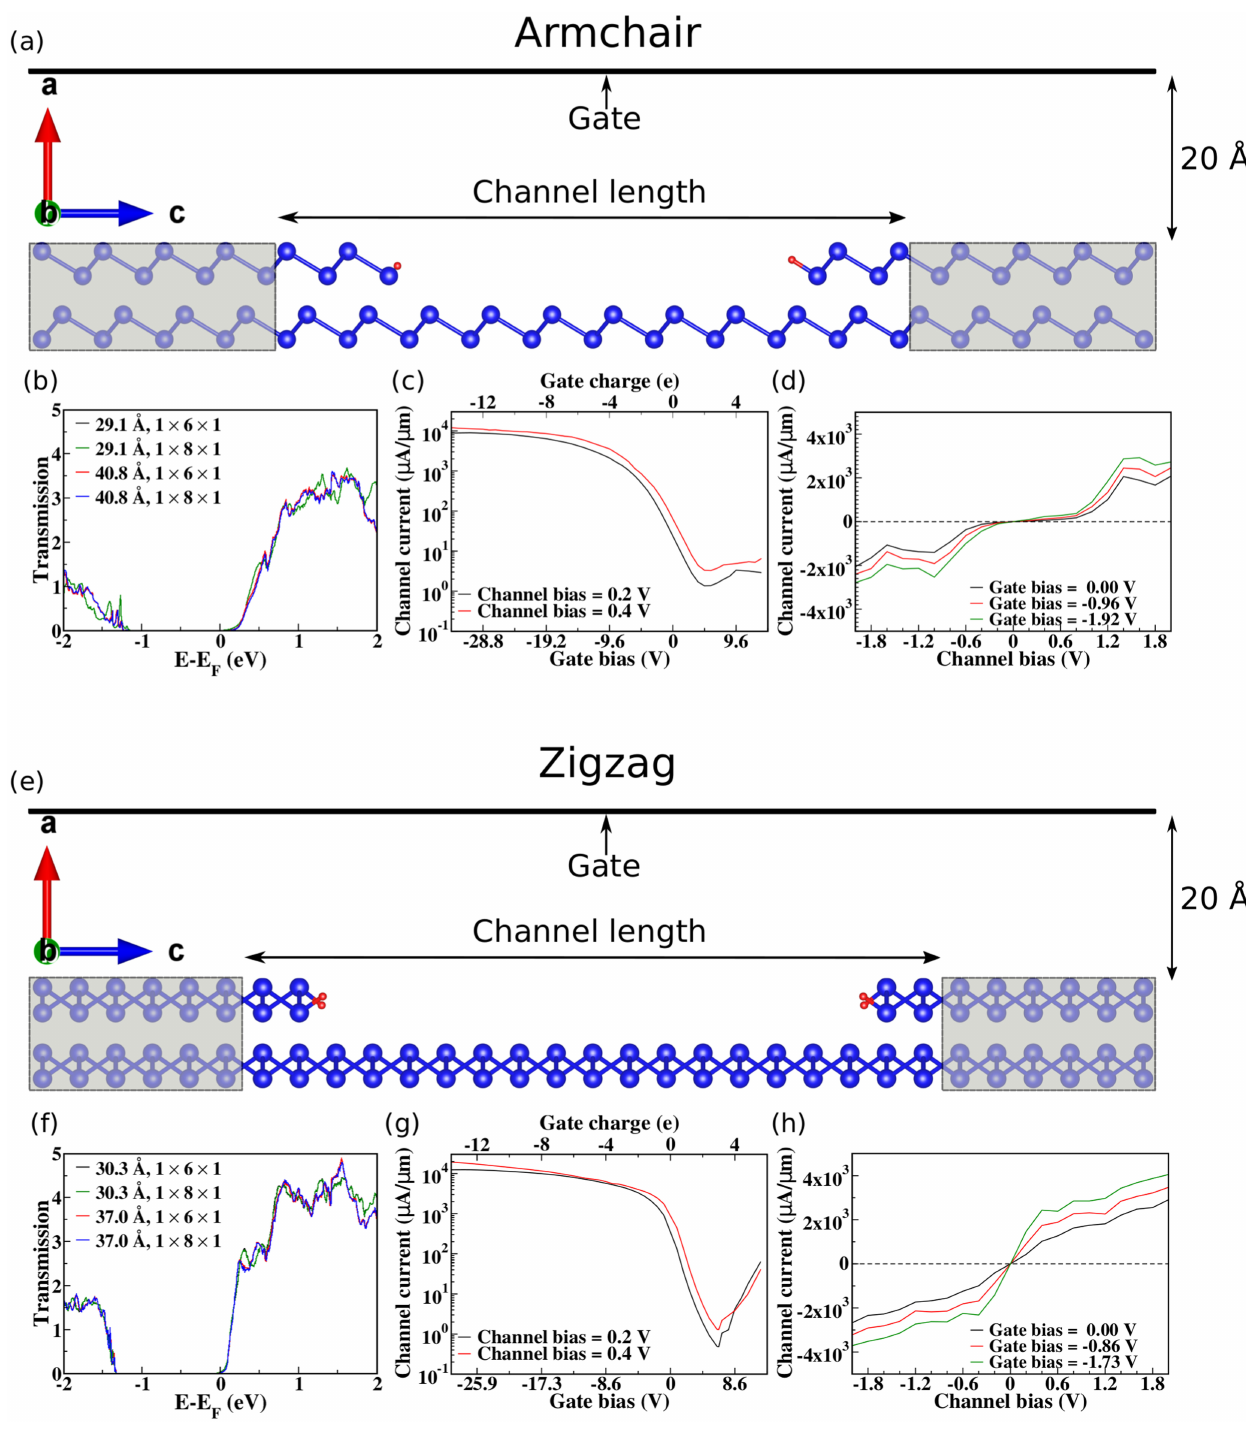
Fig. 2 Armchair and zigzag devices. a , e Schematic representations. Blue and red spheres represent the P and H atoms, respectively, and gray color marks the electrodes. b , f Transmission spectrum for different channel lengths and k-meshes. c , g Channel current as a function of the gate charge for different channel biases. d , h I – V characteristics for different gate